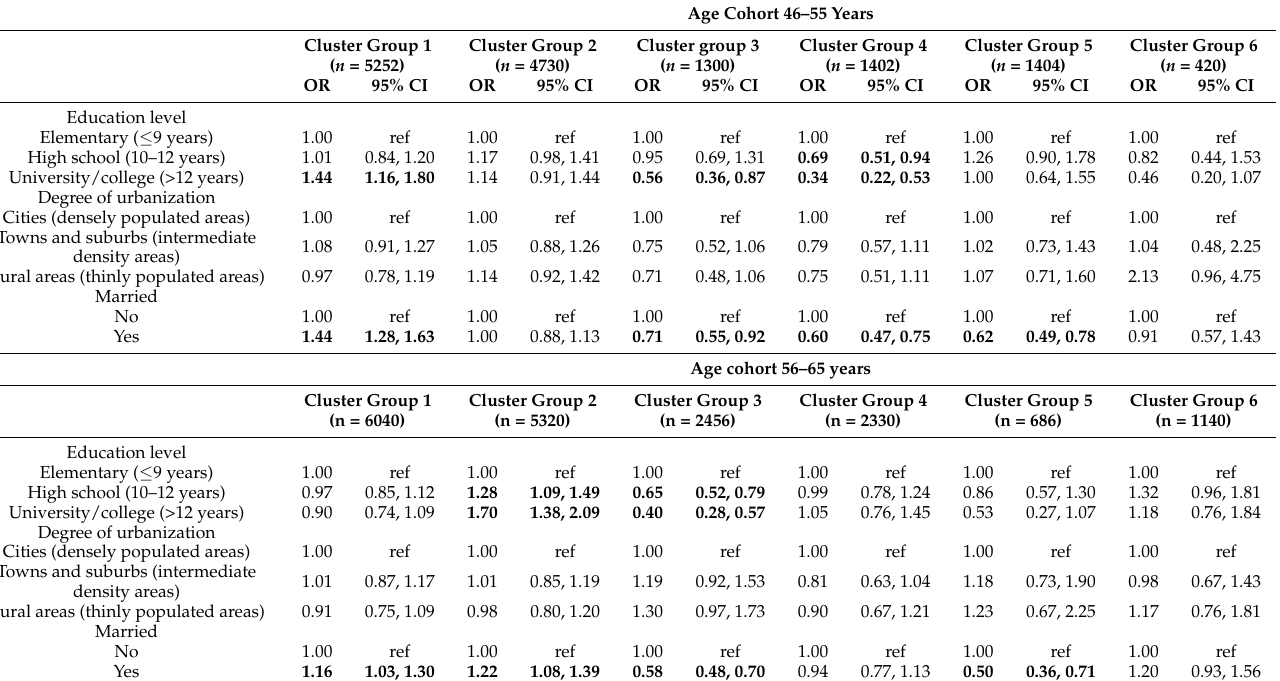
Table 4. Conditional odds ratios (OR) with 95% confidence intervals (CI) for associations between sociodemographic factors and sequence clusters among the age cohorts 46–55 years and 56–65 years of